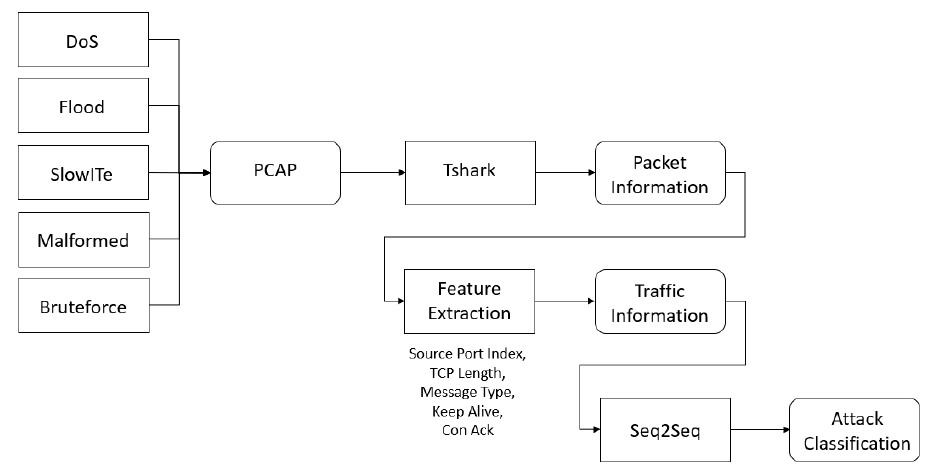
Figure 1. Malicious MQTT Traffic Detection System Structure.